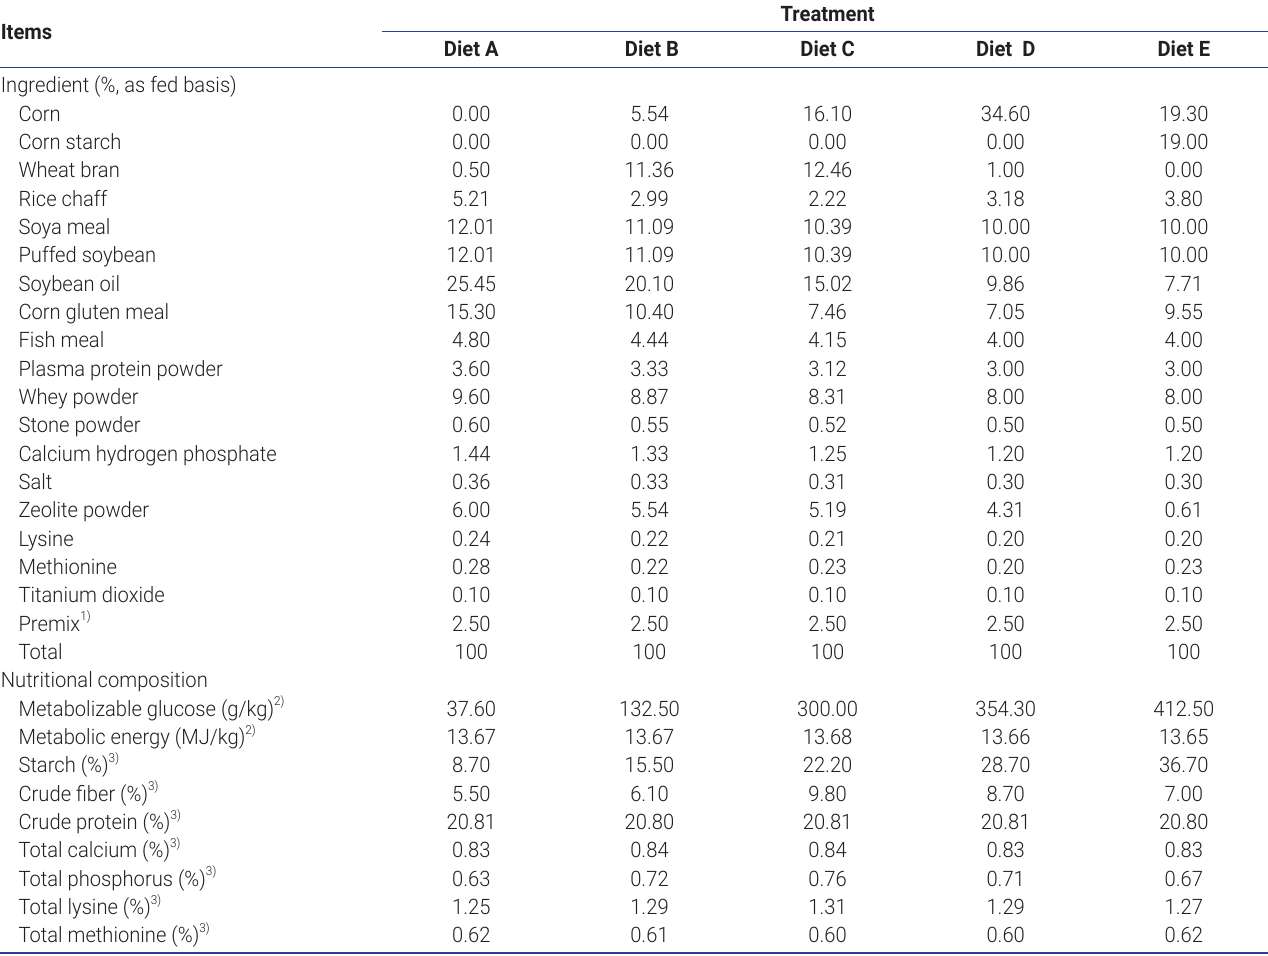
Table 2. Ingredients and nutritional composition of experimental diets in Exp 2 Items